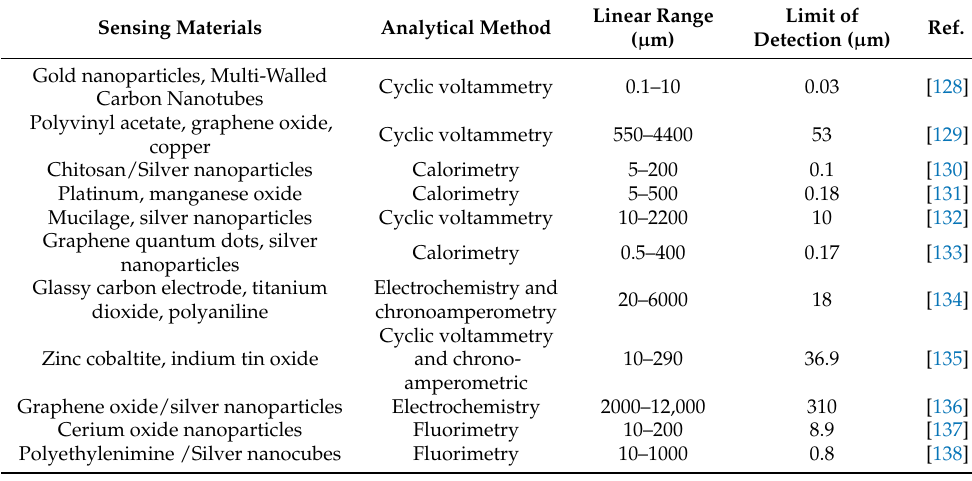
Table 2. Comparison between some of the common metallic nanomaterials that have been used for functionalization for the detection of glucose